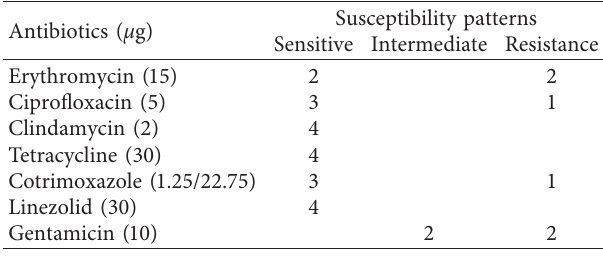
Table 4: Antibiotic susceptibility pattern of MRSA.